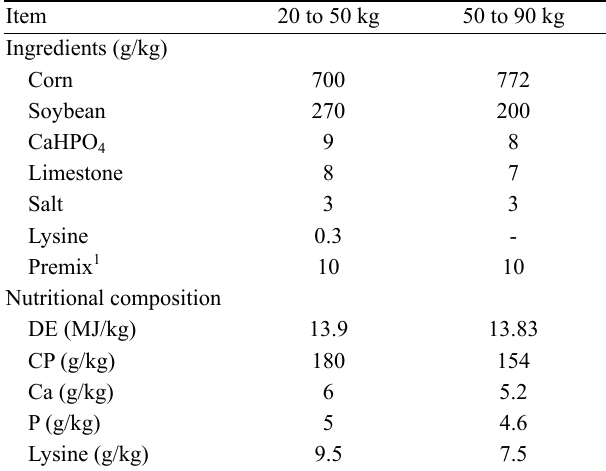
Table 1. Ingredients and nutritional composition of the basal